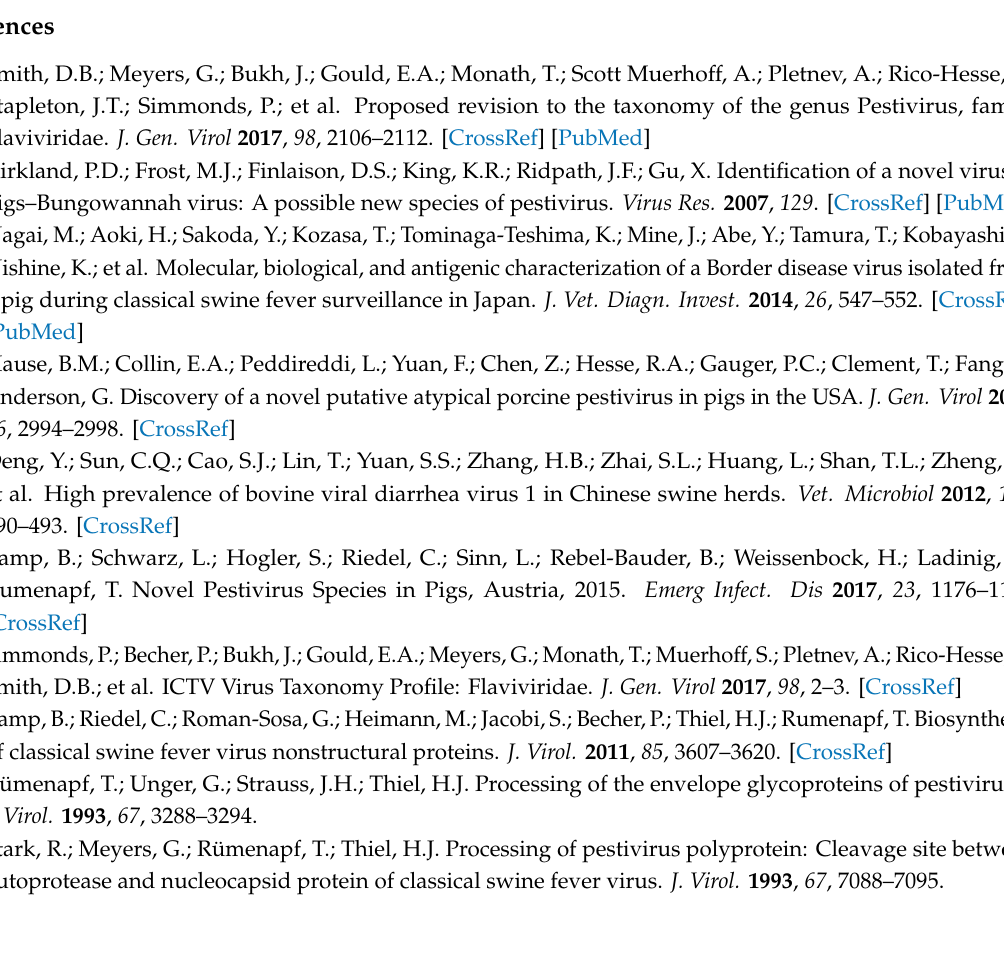
Figure S1: Detection of LINDA virus by conventional RT-PCR in oro-nasal